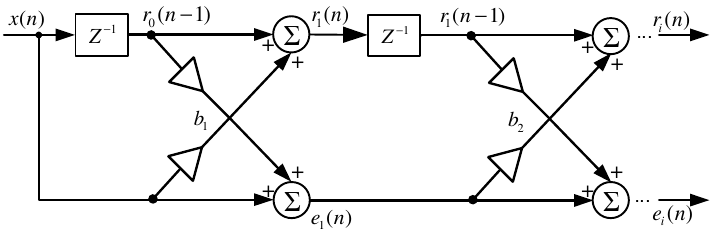
Figure 15. The finite impulse response lattice digital